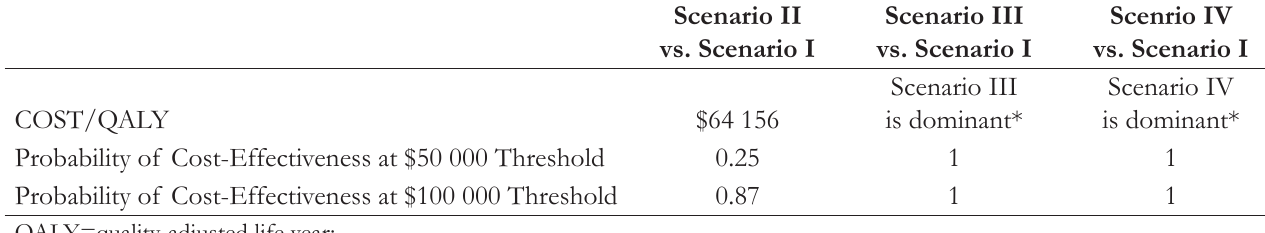
Table 3. Incremental Costs/QALY for each Treatment Group Relative to Scenario